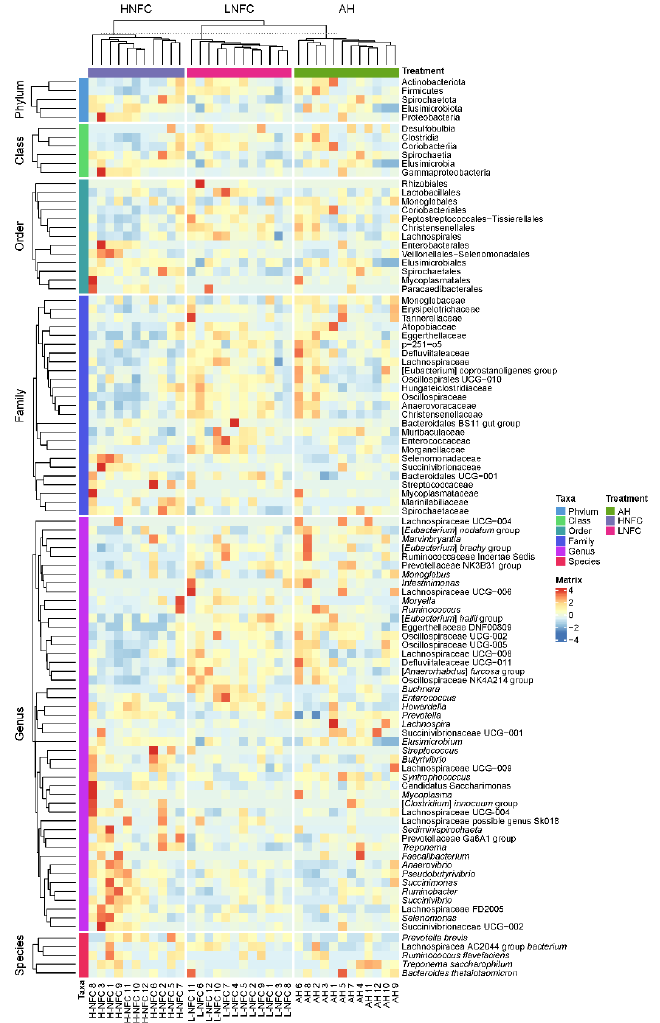
Figure 2. Rumen microbial community variation in three dietary treatments. The columns of the heatmap represent the samples collected from each animal, and rows correspond to the bacteria that significantly changed under the influence of dietary treatments at different phylogenetic levels. The relative abundance was normalized by z-scores across different samples. Taxa are separately clustered at different phylogenetic levels and dietary